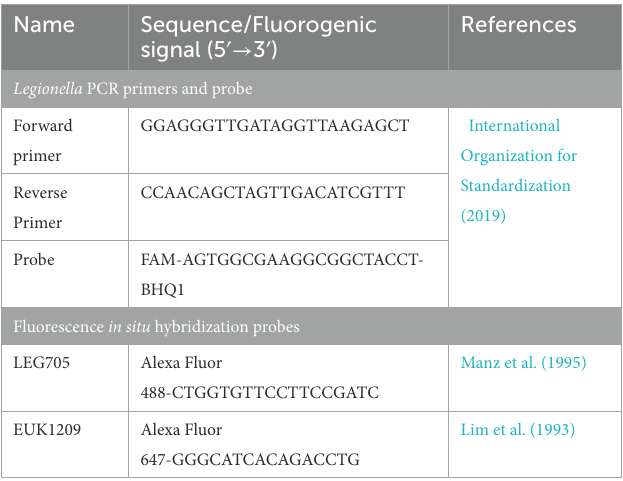
(Supplementary Figure S2). During optimization of the protocol, control samples containing predominantly dead or alive Legionella cells